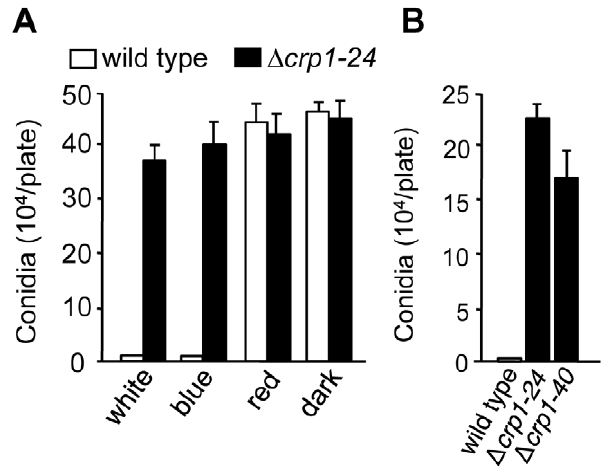
Figure 6. CRP1 regulates lesion formation in C. zeae-maydis . Maize leaves were inoculated with a suspension of conidia (10 5 ) of wild type or the D crp1-24 mutant, and the inoculated maize plants were incubated in the green house for 12 days. DAI=days after inoculation.